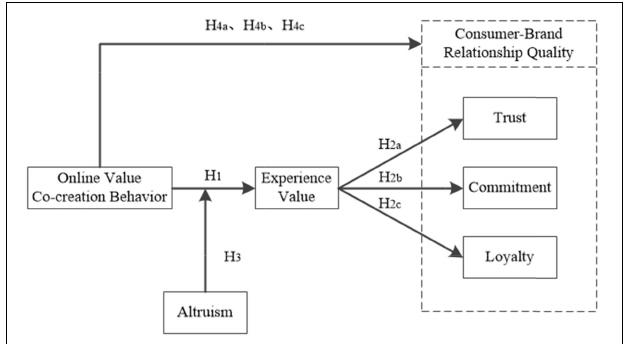
FIGURE 1 | The model of this